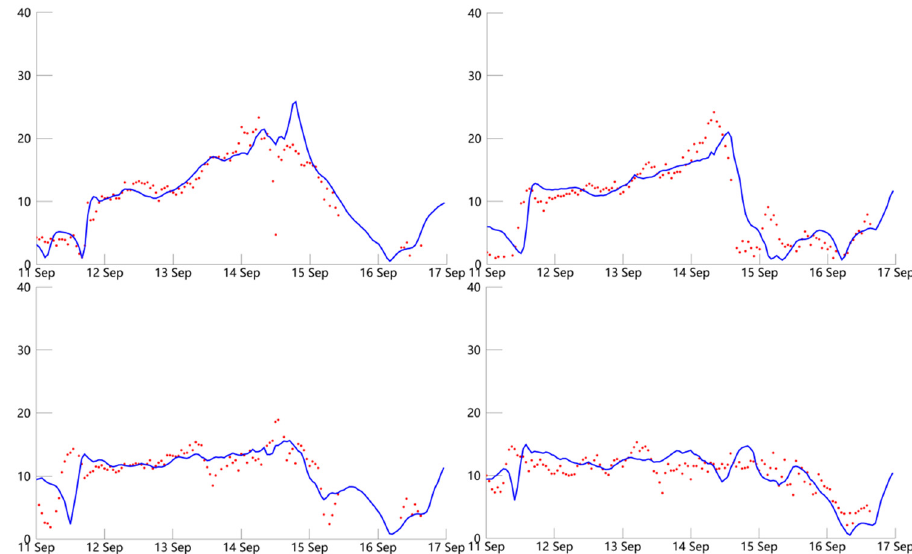
Figure 4. The temporal distributions of wind speeds (m/s) obtained from experiment 12 (blue line) and the buoy observations (red dot) during typhoon Dujuan at the locations of four buoys.